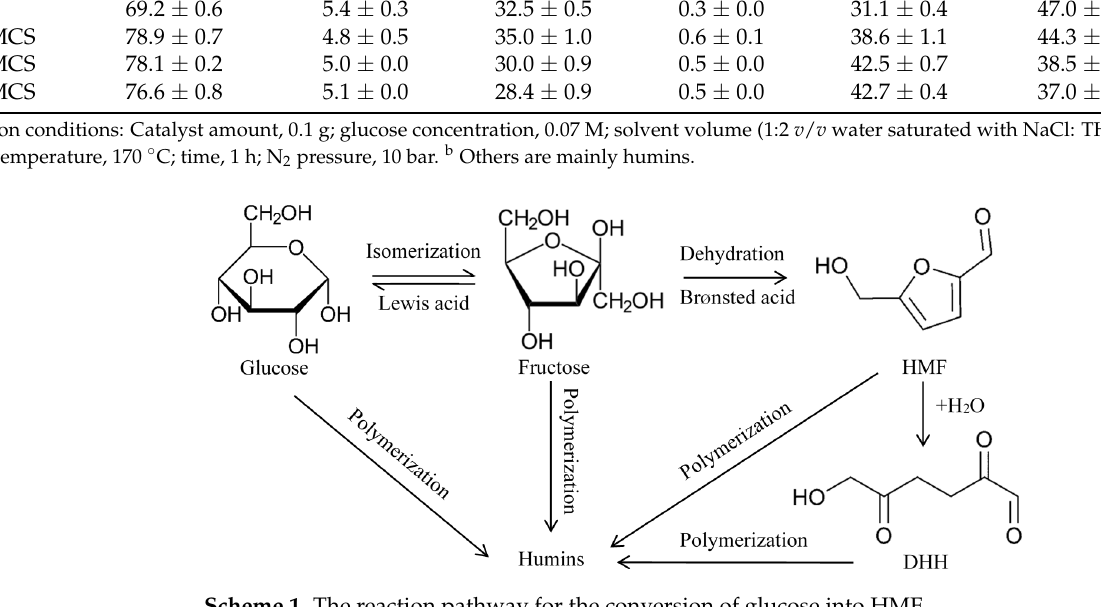
Scheme 1. The reaction pathway for the conversion of glucose into